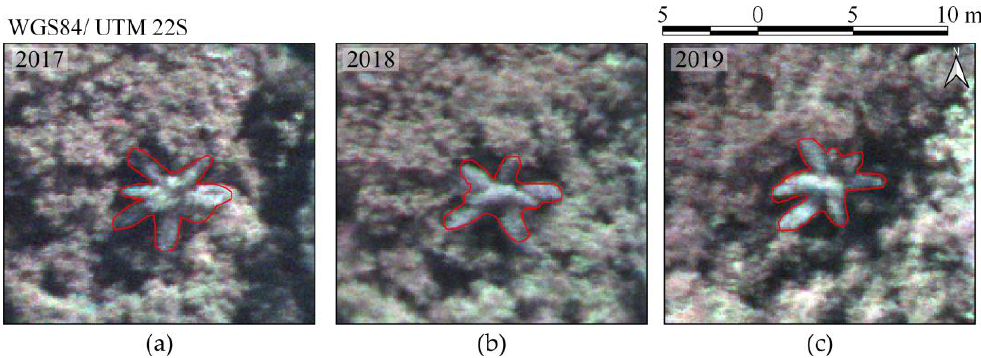
Figure 6. The spatial difference in the leaves of one sample of SR tree in each dataset (R: 690.28 nm; G: 565.10 nm; B: 519.94 nm; automatic contrast from QGIS software, version 3.0.0): ( a ) 2017, ( b ) 2018, and ( c ) 2019.